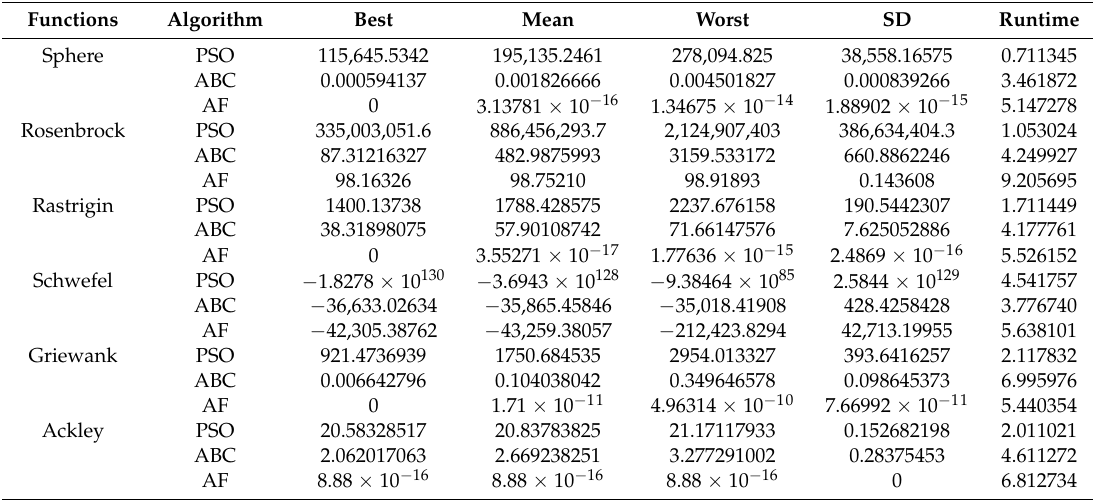
Table 7. Comparison of statistical results obtained by AF, PSO, and ABC in 100-dimensional space.